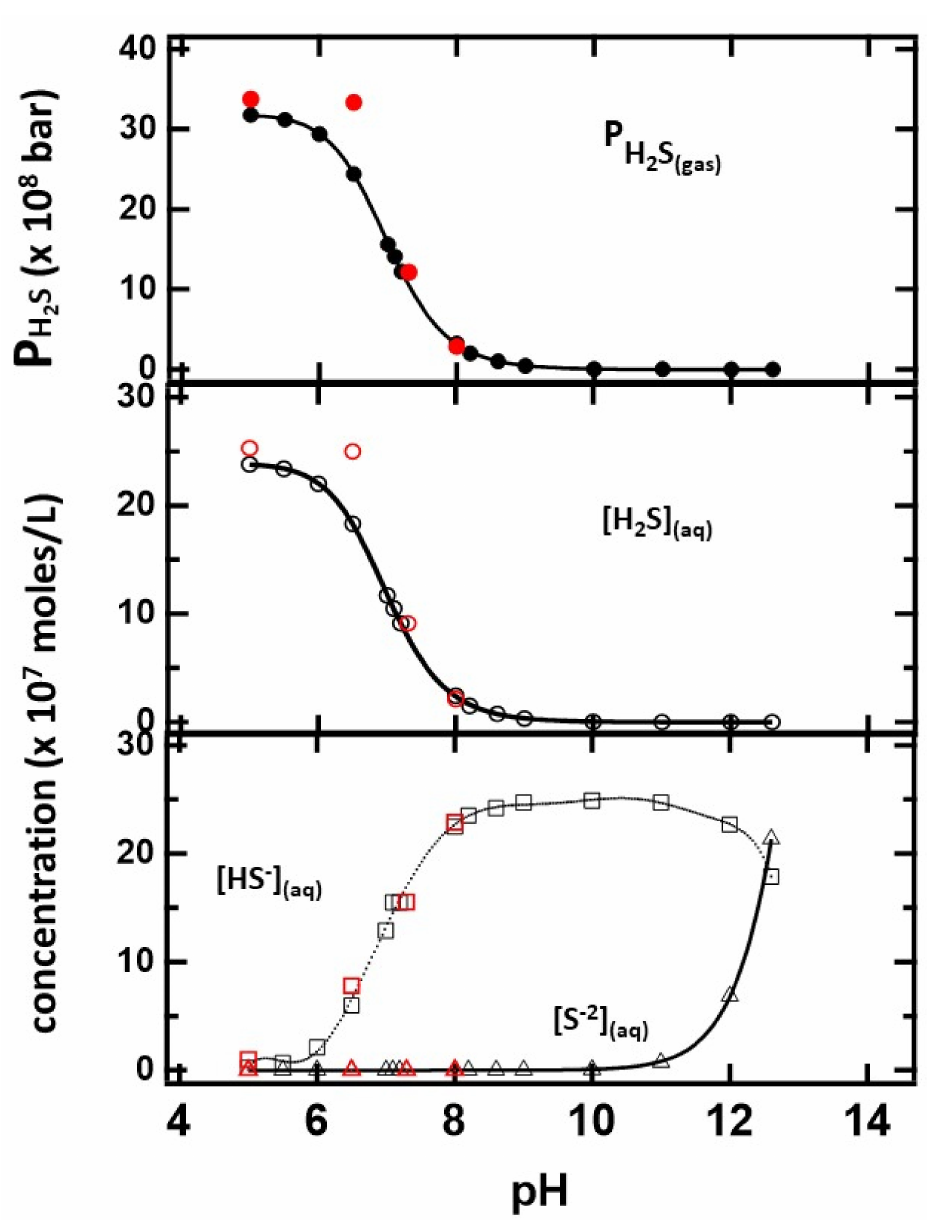
Figure 6. The distribution of sulfides in the gas and solution phases as a function of pH determined from minimization of the Gibbs free energy. The number of moles of sulfur is 2.5 × 10 − 6 moles for the indicated pH values. Values obtained from identical CaS amounts are indicated in